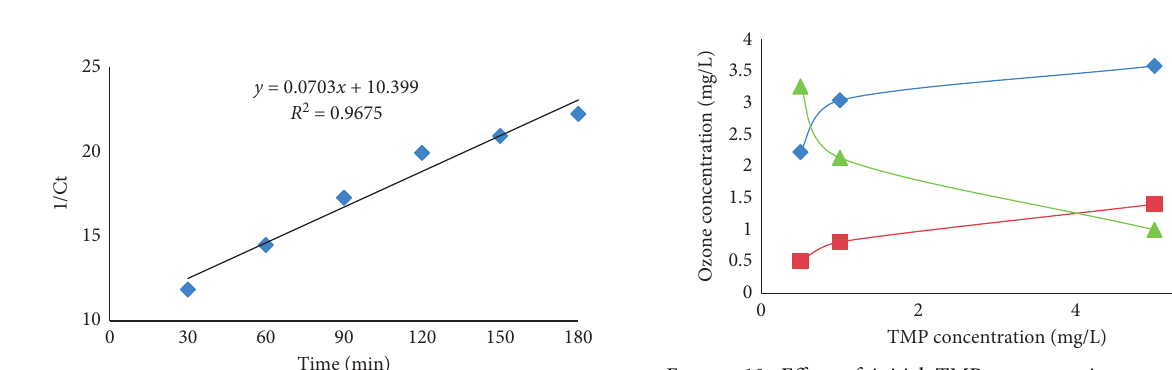
Figure 10: Effect of initial TMP concentrations on ozone de- composition (ZnO � 50mg/L); • : consumed ozone, ◆ : residual ozone, and ▲ : outlet